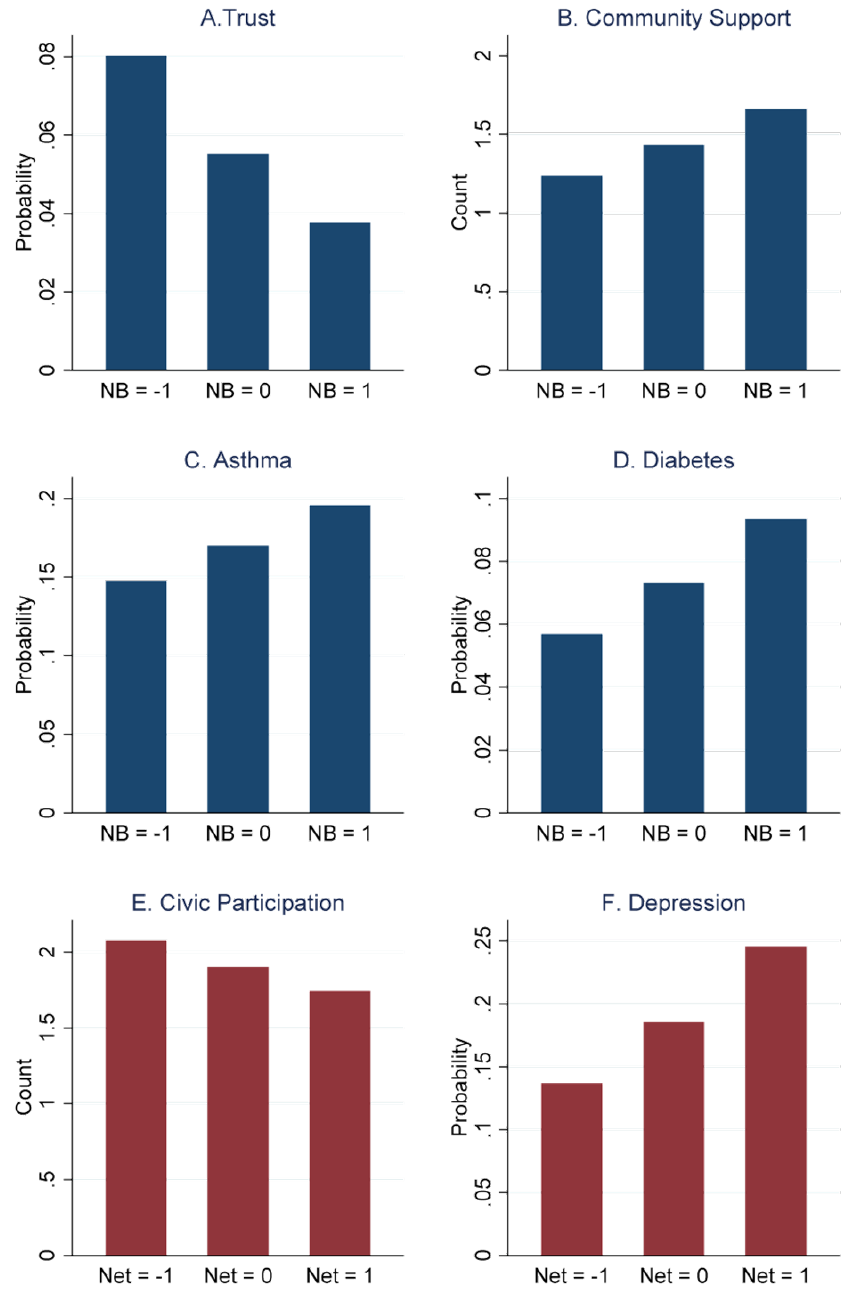
Figure 3: (A to F). Predicted outcomes based on Model 3 of Table 3. A to D display estimates of outcomes associated with neighborhood disadvantage (NB). E to F display estimates of outcomes associated with network disadvantage (Net). For each outcome, predictions are shown for average neighborhood or network disadvantage (NB/Net=0) as well as for one standard deviation below and above the mean (NB/Net =-1,1). All control variables are held at their mean.